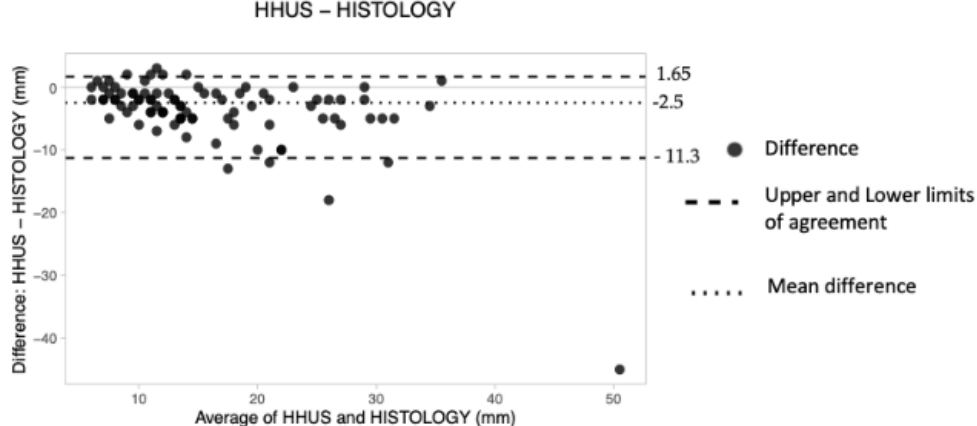
Figure 6. The Bland–Altman scatter plot shows the agreement of measurements between hand-held ultrasound (HHUS) and histology. Millimeters